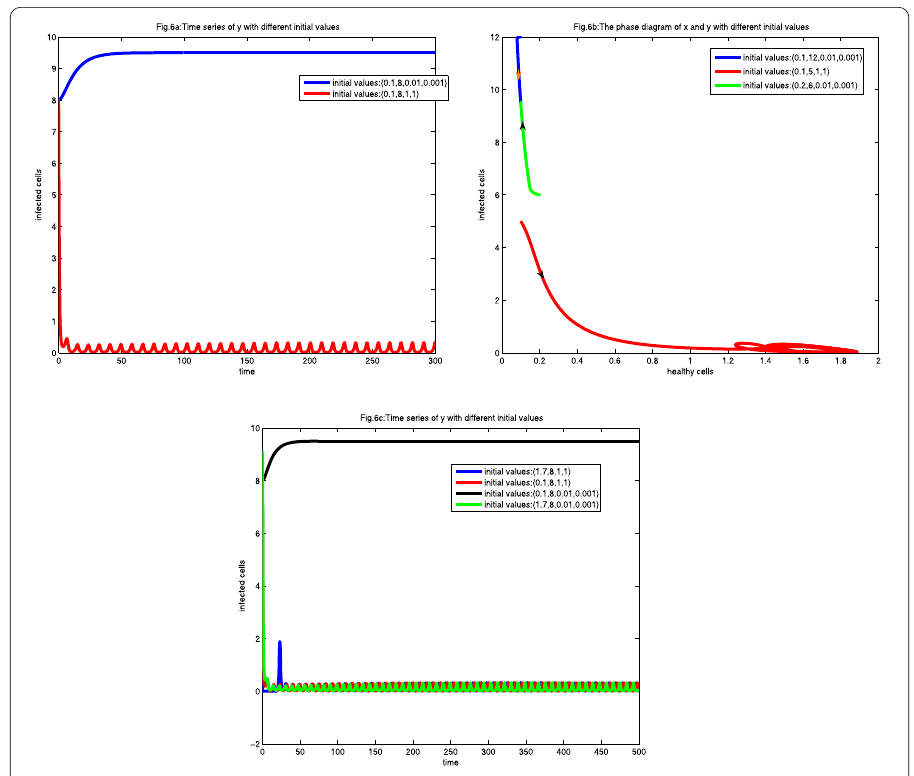
Figure 6 Figure 6( a ) is the diagram of time series of y at a = 0.1 and h = 0.3 with different initial values. Figure 6( b ) is the phase diagram of x and y with different initial values. Figure 6( c ) is the diagram of time series of y with different initial